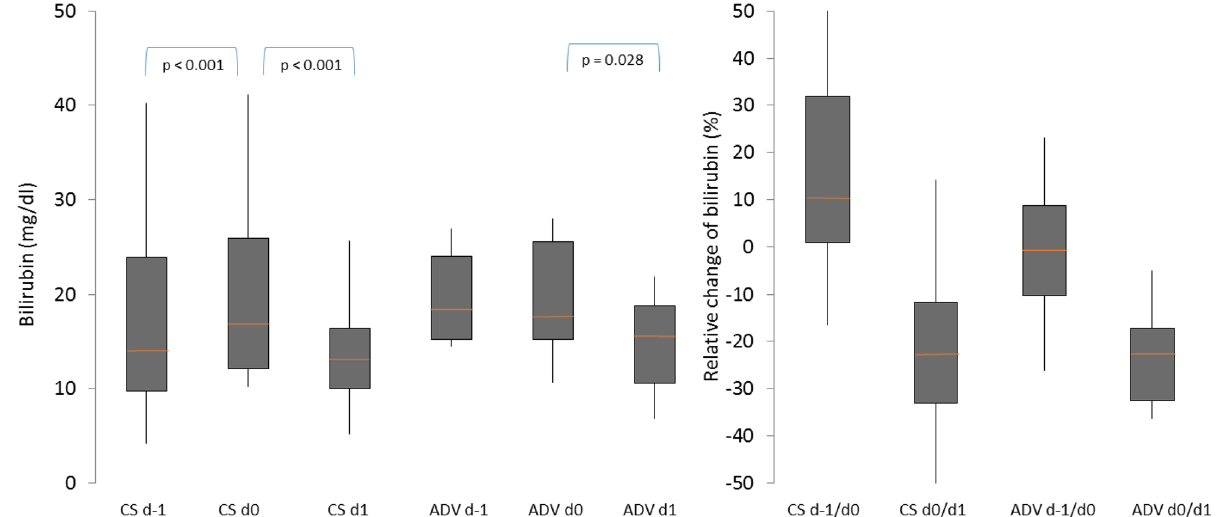
Figure 2. Development and relative reduction in bilirubin levels in patients with CytoSorb and ADVOS therapy. d–1: day before treatment, d0: shortly before treatment, d1: directly after treatment, CS: CytoSorb, ADV: advanced organ support; orange line represents the median, grey boxes the interquartile range and the whiskers are limited to 1.5 times the interquartile